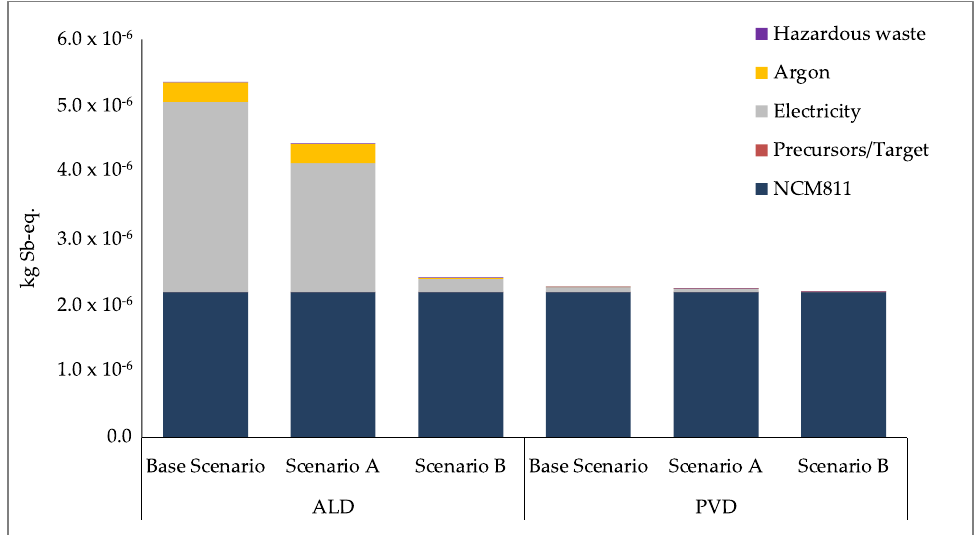
Figure 10. LCIA Results of the Scenario Analysis per 1 g of Input NCM811 for the Material Resources (metals/minerals) Impact Category.